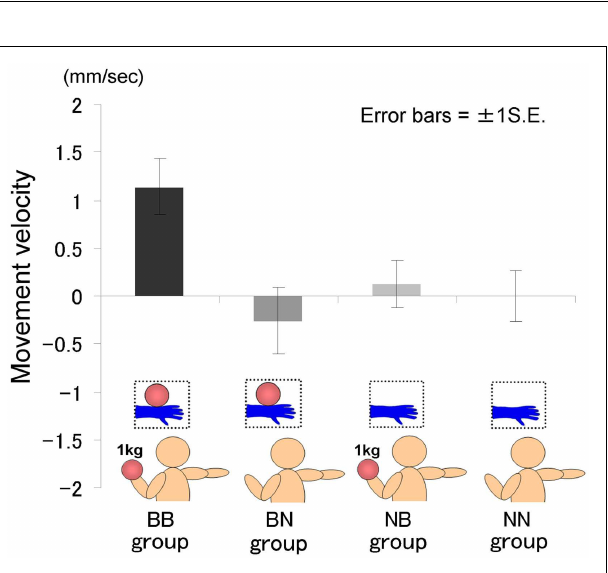
FIGURE 2 |Time course of the height of the hand in each group in Experiment IA.